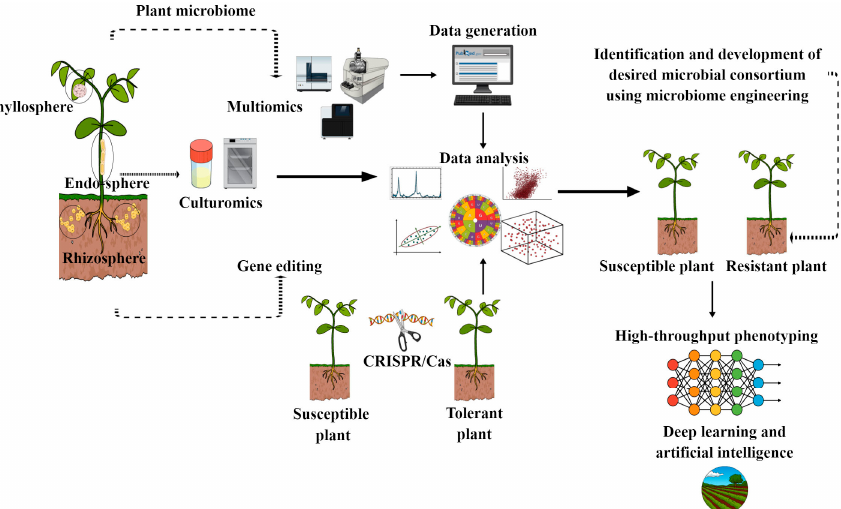
Figure 5. Overview of different molecular, synthetic and high-throughput tools for developing tai- lored beneficial microbiome for disease resistance in sustainable agriculture. This figure also shows the role of phenotyping, artificial intelligence and deep learning for monitoring the functionaries of tailored beneficial microbiomes under field conditions. tailored beneficial microbiomes under field